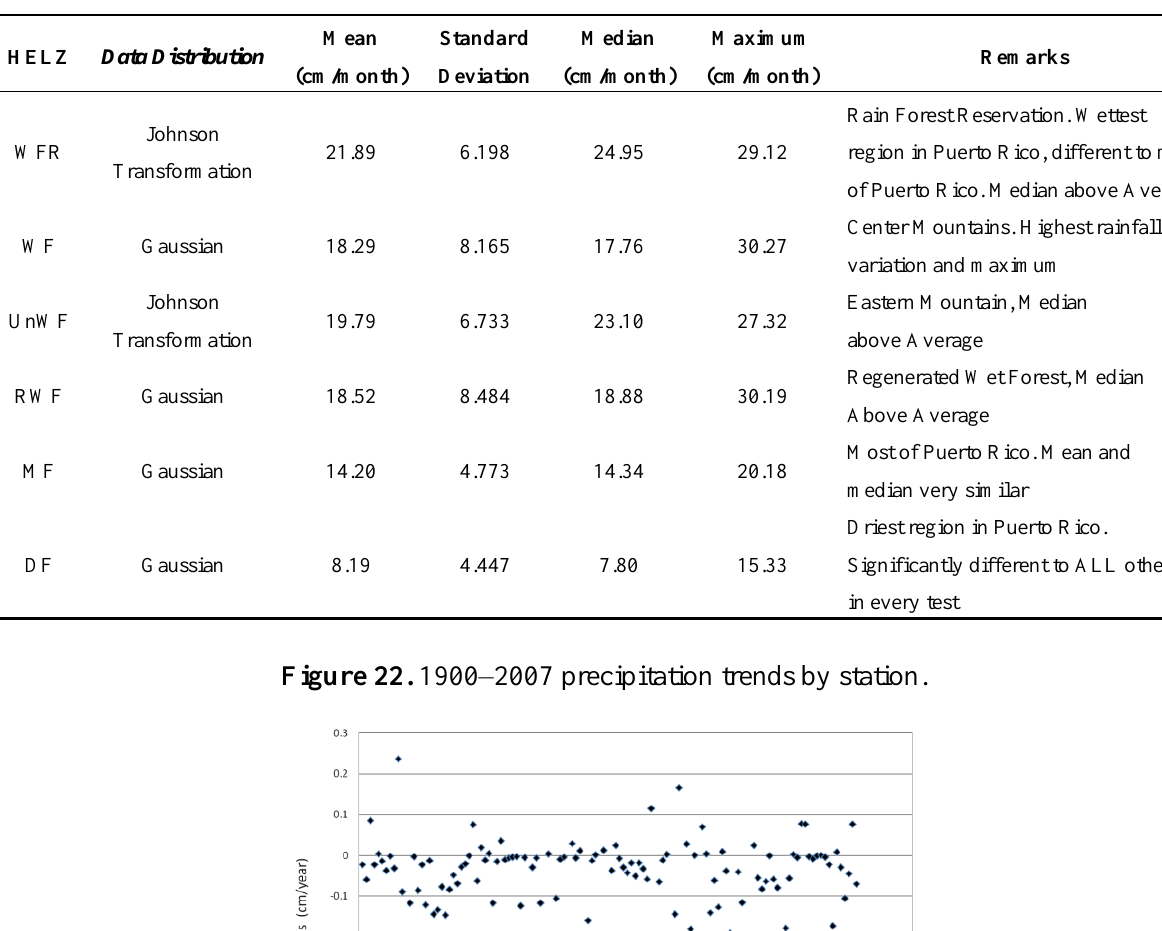
Table 5. Holdridge ecological life zones distributions and descriptive statistics.